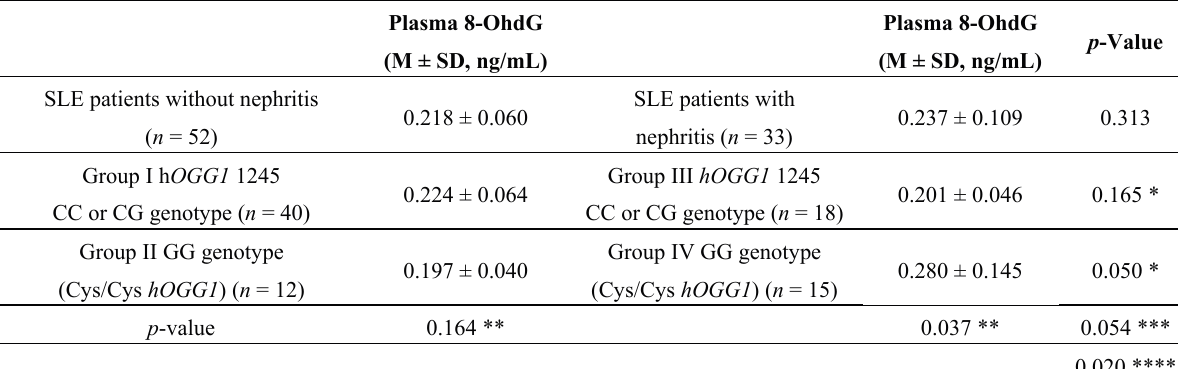
Table 4. Plasma levels of 8-OHdG in SLE patients with or without nephritis as related to the hOGG1 C1245G